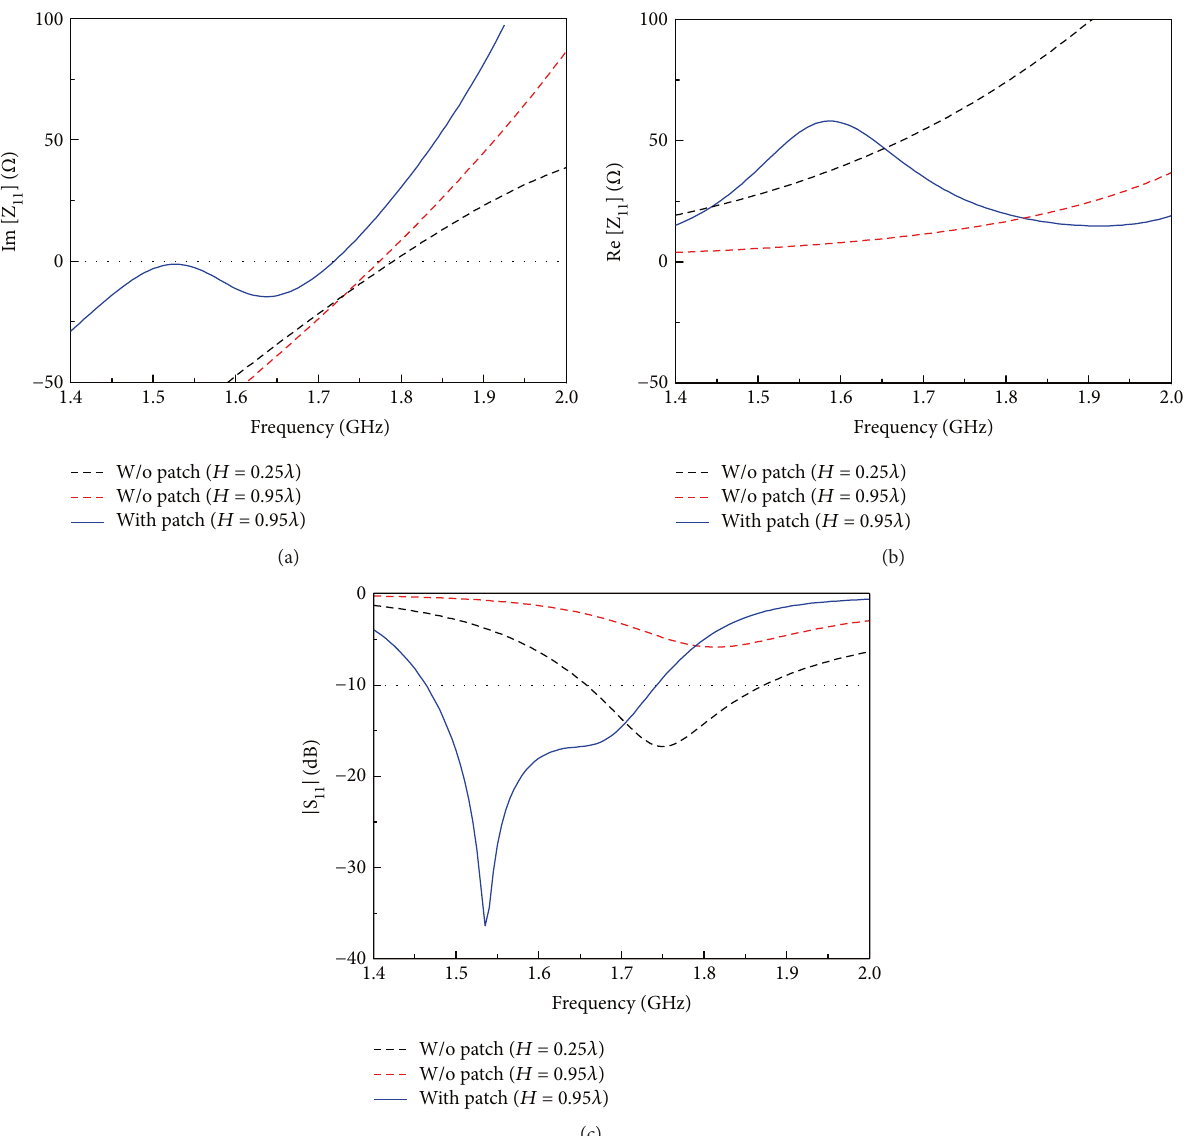
, (b) real part of Z , and (c) |S | values of the single-dipole antenna in di ff erent con fi gurations 11 11 11